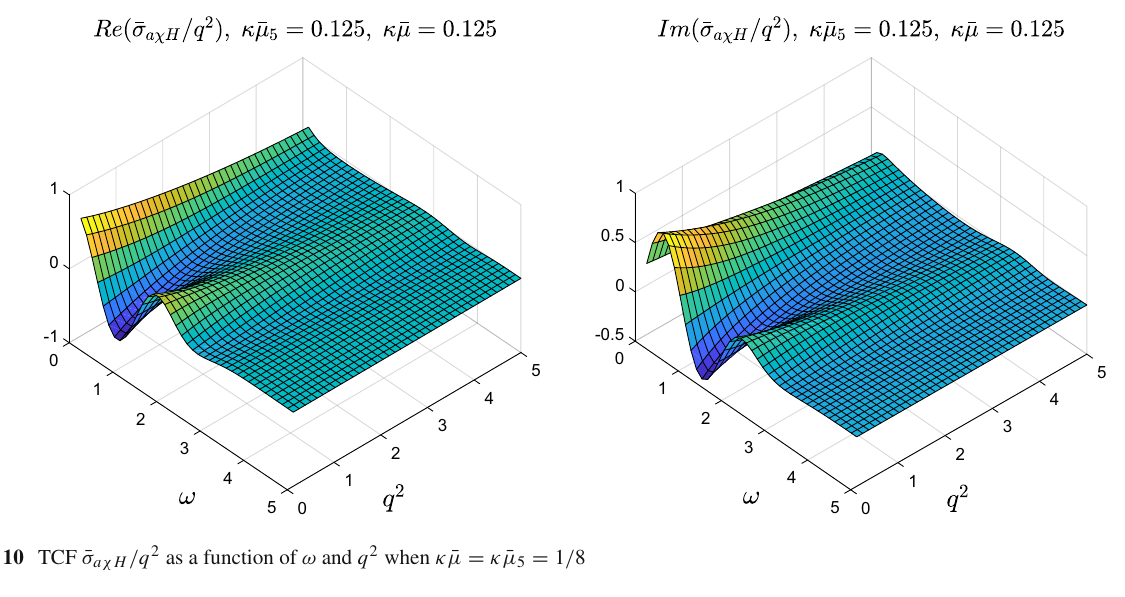
Fig. 10 TCF ¯ σ a χ H / q 2 as a function of ω and q 2 when κ ¯ μ = κ ¯ μ 5 = 1 / 8